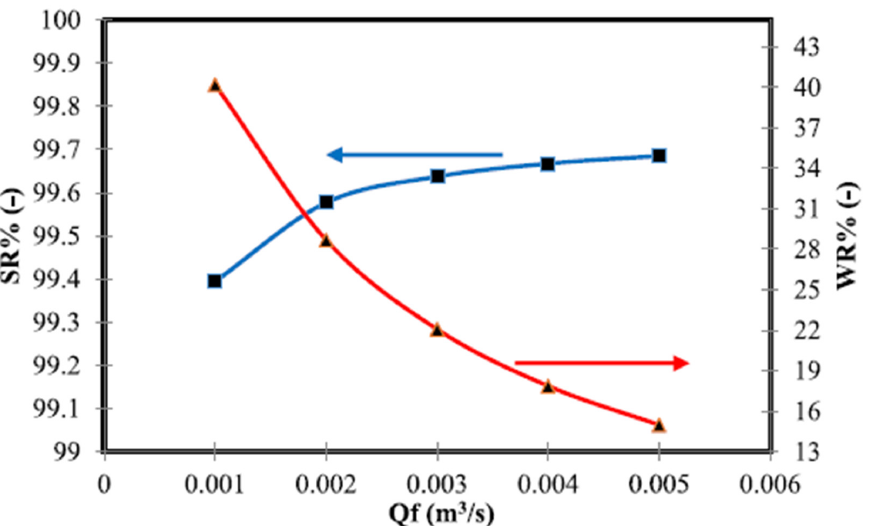
Figure 11. Effect of feed water flow rate on the water distillate and salt concentrations (WR; water recovery, SR; solute rejection, 𝑄 (cid:3033) ; feed water flow rate), adapted from [23].